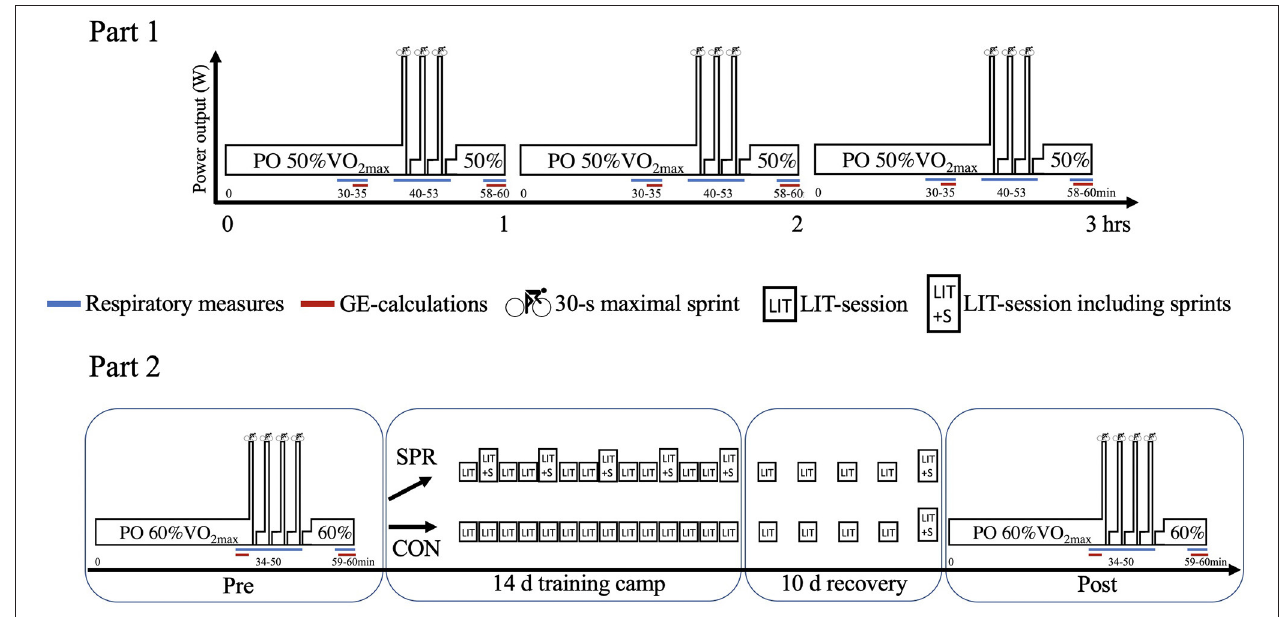
FIGURE 1 | Schematic presentation of Part 1 (upper panel) and Part 2 (lower panel). Part 1 included 12 elite cyclists who performed a 3-h low-intensity training (LIT)-session including three sets of 3 × 30-s maximal sprints interspersed by 4min recovery. Part 2 included 18 elite cyclists who completed a performance test including 4 × 30-s maximal sprints interspersed by 4min recovery, which was performed before (Pre) and after (Post) a 14-d training camp and subsequent 10-d recovery period. A control group (CON, n = 9) performed only LIT-sessions during the training camp, while a sprint group (SPR, n = 9) included 12 × 30-s sprints on five of the LIT-sessions. Both SPR and CON performed a self-administered habituation-exercise trial of ∼ 1h including 4 × 30-s sprints the day before Pre and Post.